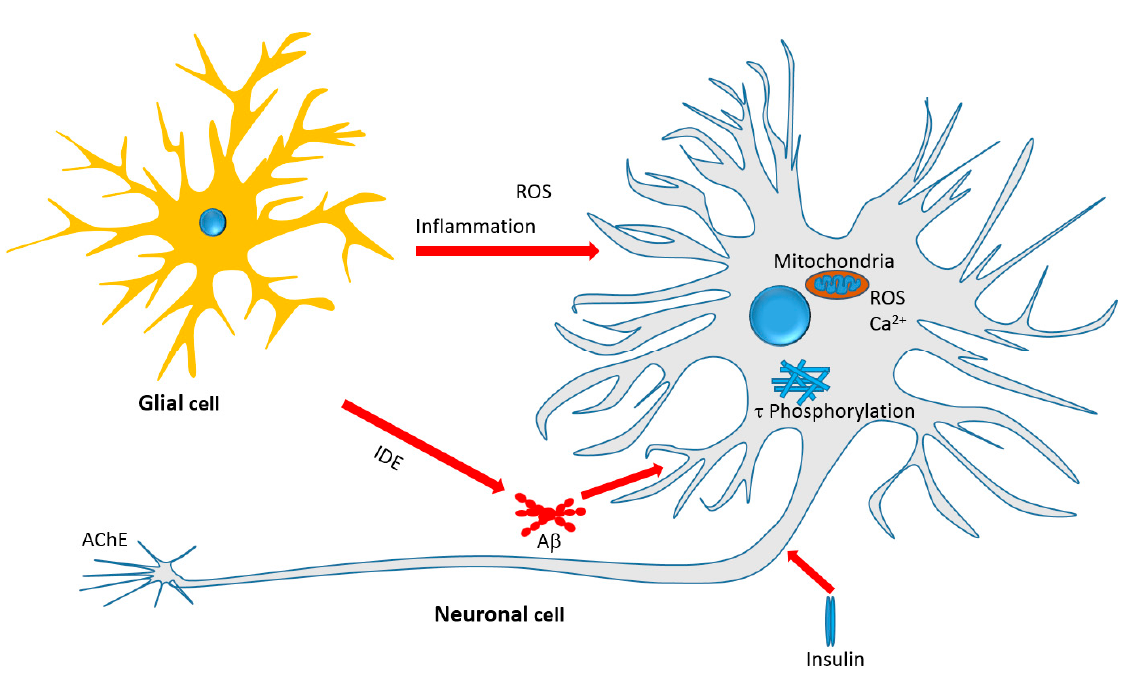
Figure 4. Therapeutic targets of iridoids and other monoterpenes discussed in this review. Antiinflammatory effect, amelioration of oxidative stress, mechanisms related to A β formation, aggregation and clearance, τ -protein phosphorylation and aggregation, and neurotoxicity associated with mitochondrial dependent and independent mechanisms are among the therapeutic targets.